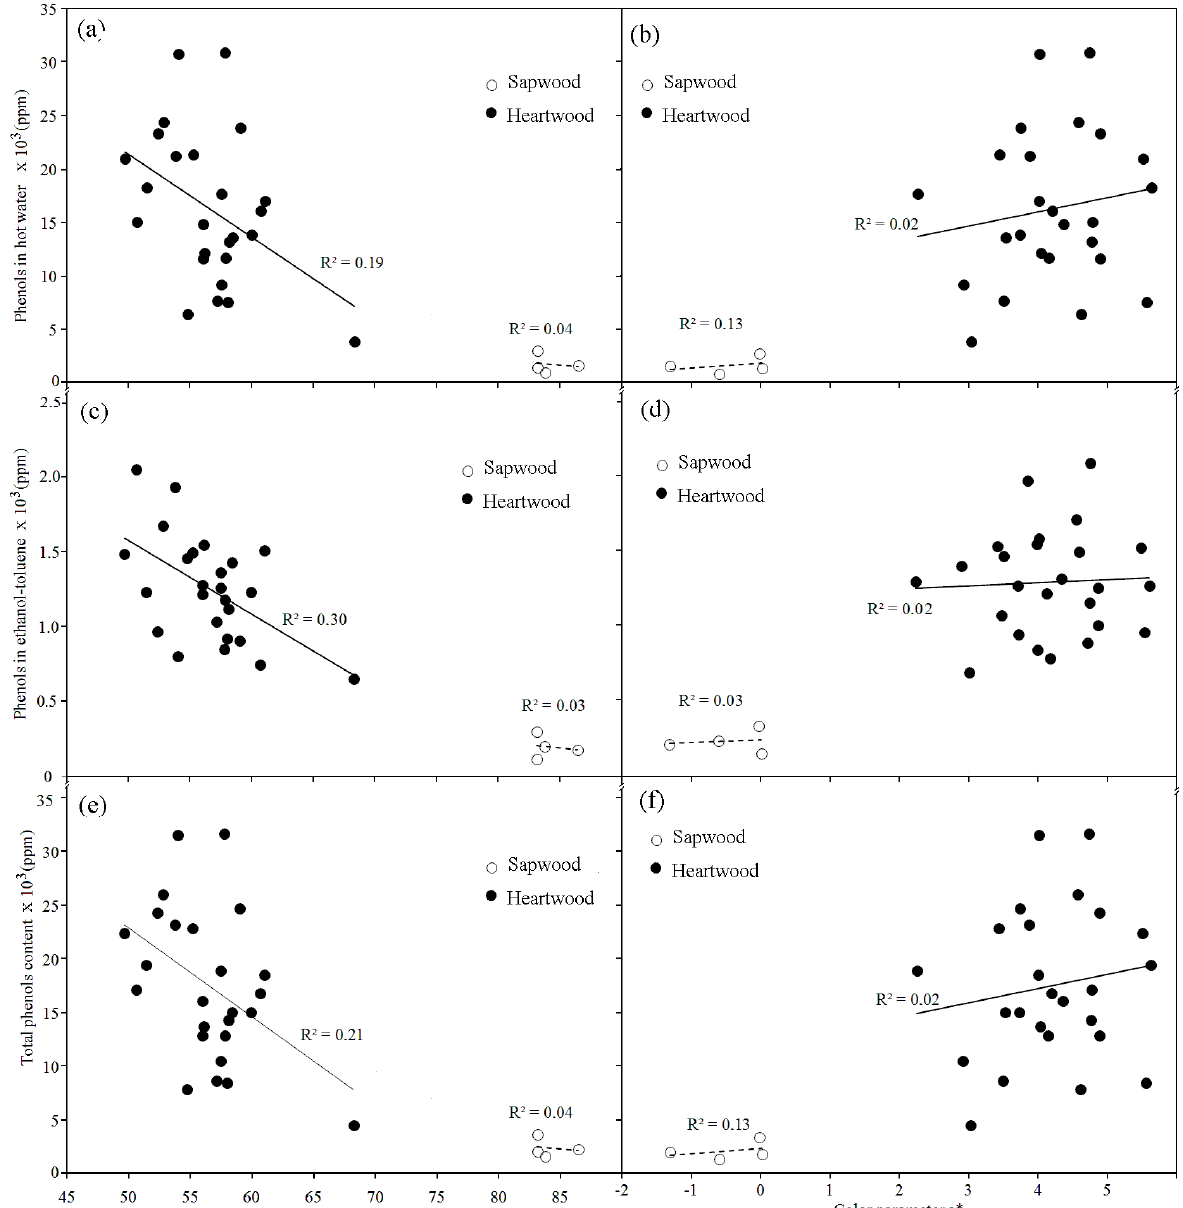
Figure 3. Relationship between phenol content using tannic acid and color parameters in Acacia mangium